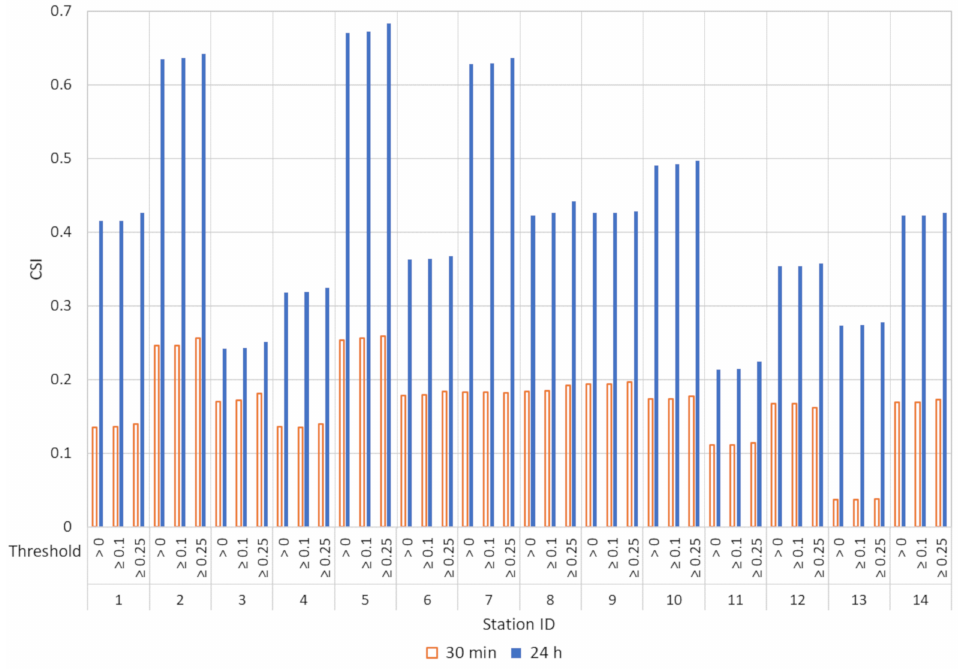
Figure 4. Critical success index (CSI) results by station for di ff erent analyzed thresholds.